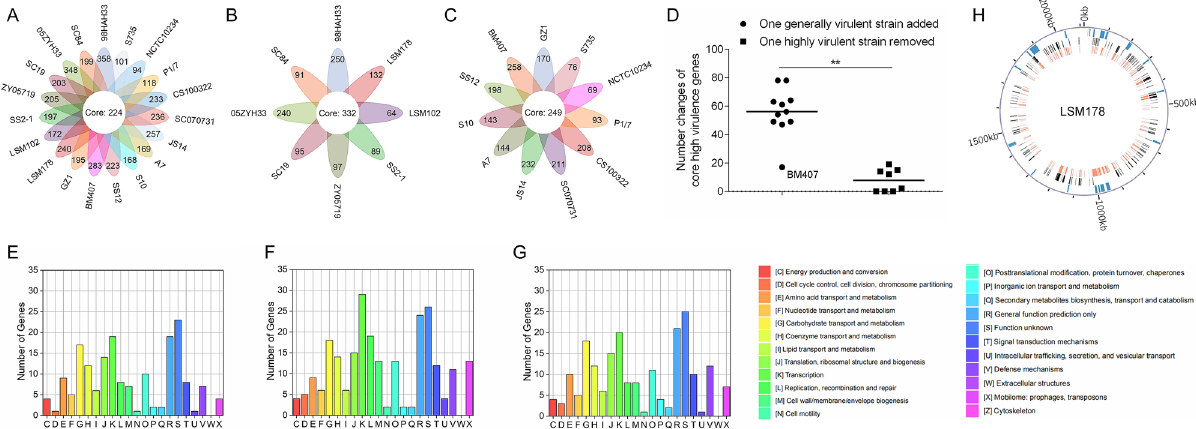
Figure 6. Chromosomal features of LSM178. ( A ) Venn diagram of the special genes of each strain from LSM178 clade. The special genes for each strain were extracted with T15 as the reference. The overlap was named core virulence genes. ( B ) Venn diagram describing the special genes of HVSs. ( C ) Venn diagram describing the special genes of generally virulent strains. ( D ) Changes of core high virulence genes. P < 0.01 **. ( E–G ) COG function classification of the core genes from ( A–C ) respectively. ( H ) Locations of GIs (blue), core general virulence genes (black) and core high virulence genes (red) in LSM178 genome. The images of A , B